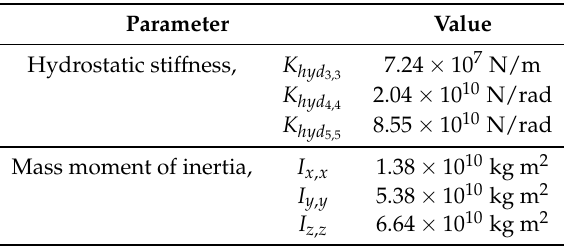
Table 7. Characteristics of the investigated